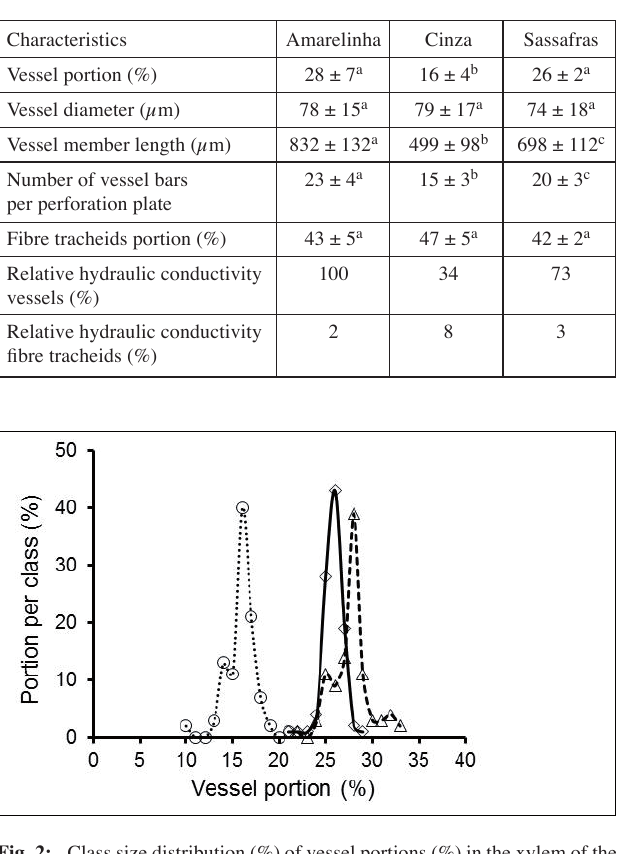
Fig. 2: Class size distribution (%) of vessel portions (%) in the xylem of the phenotypes “Amarelinha” (rough dotted line), “Cinza” (fine dotted line), and “Sassafras” (full line). Class size: 1 %. Measuring area: 1 mm².